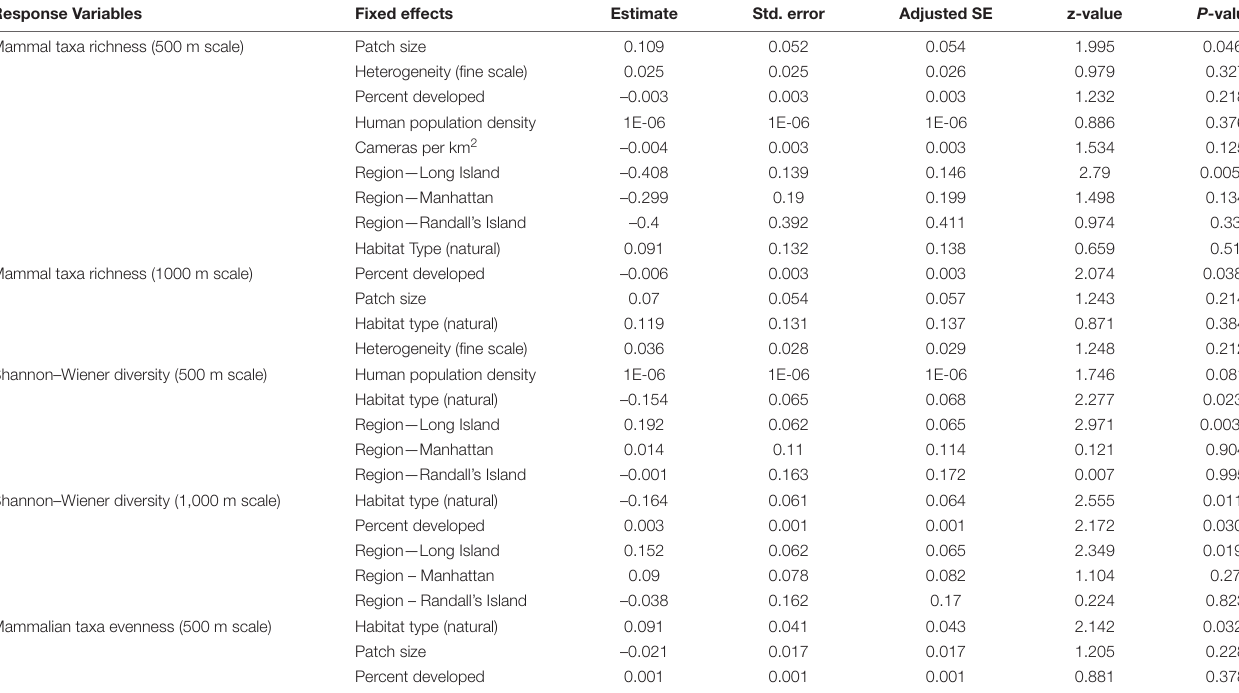
TABLE 5 | Best supported models for each response variable for mammalian diversity based on averaging of parameter